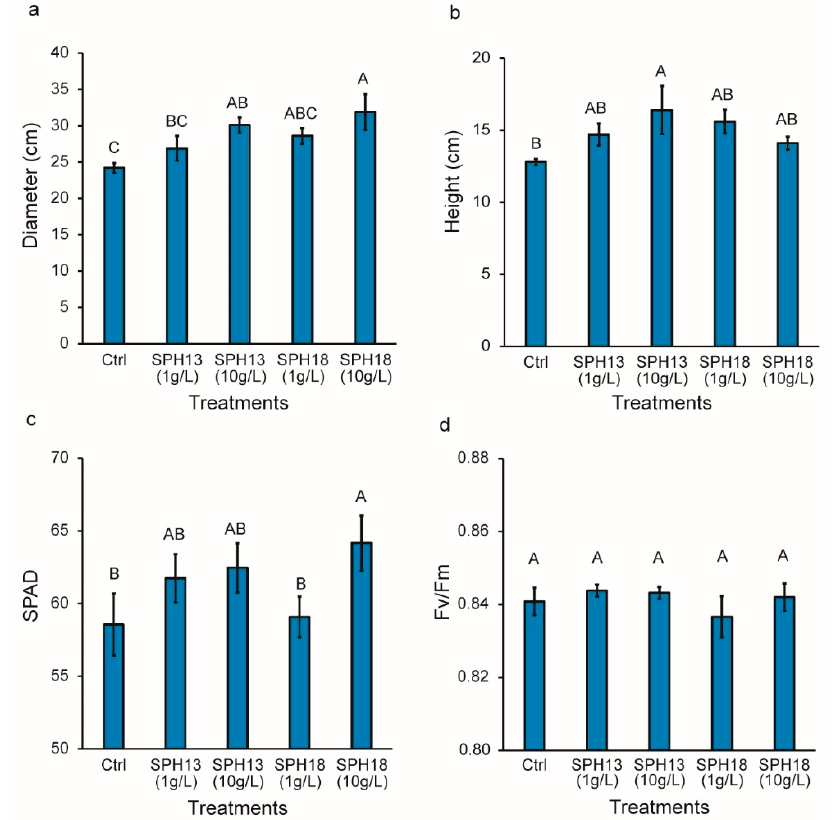
Figure 1 . ( a – d ) Impact of SPH13 and SPH18 on plant growth parameters (plant diameter and height), chlorophyll content and maximum quantum yield of photosystem II (Fv/Fm). ( a – d ) Growth and photosynthesis-related measurements were performed on Micro Tom plants two weeks after two successive substrate drench treatments with SPH13 or SPH18 at 1 and 10 g L − 1 or with water (Ctrl). ( a ) Shoot diameter and ( b ) height measurement in cm. ( c ) SPAD index and ( d ) Fv/Fm measurements on the third fully expanded leaf from the top ( n = 5, one-way ANOVA with post hoc LSD; statistical analysis was performed for each fruit colour separately, p < 0.05, means with the same letter are not significantly different). Tomato seeds were sown on 11 July 2021 for ( a – d ).